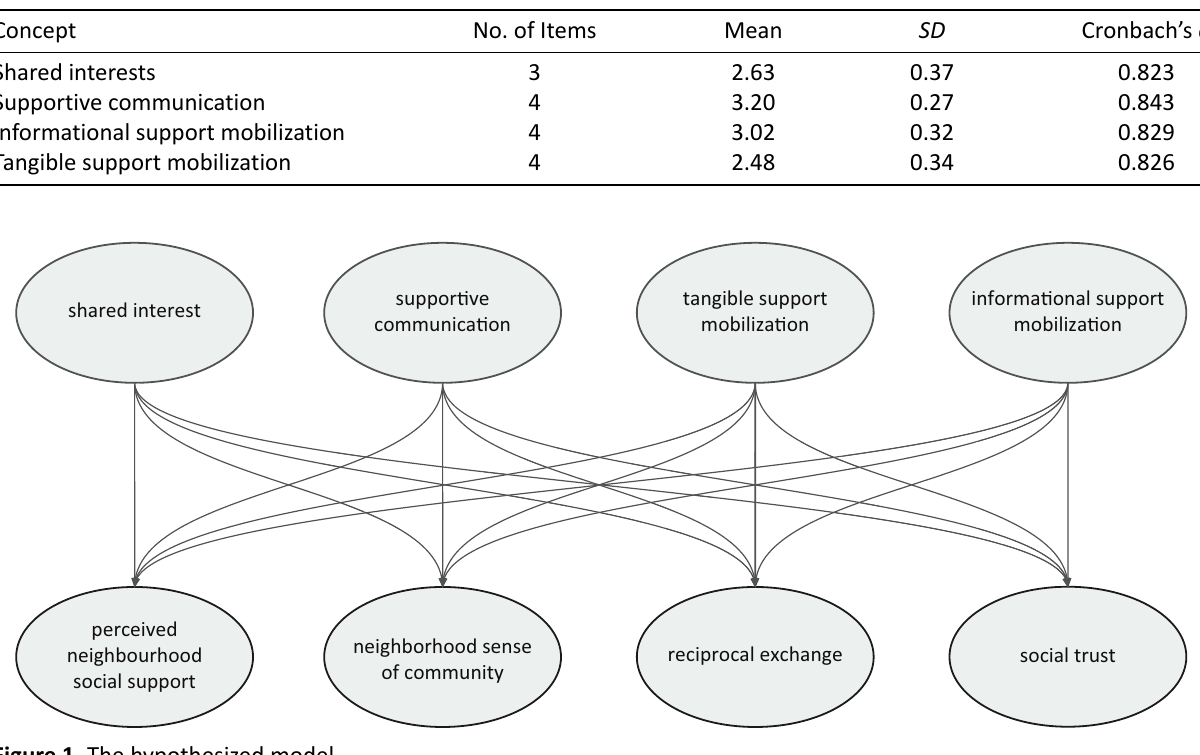
Table 3. Overview of the independent variables.